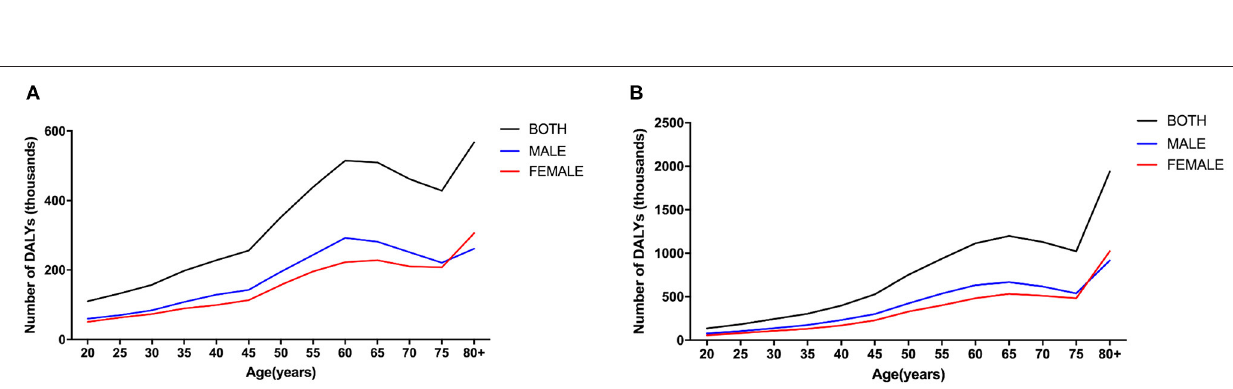
FIGURE 1 | Time trends in the global disease burden of CKD due to hypertension in 1990–2019. DALY numbers (A) , DALY rates (B) , and age-standardized DALY rates (C) . Dashed lines represent 95% confidence intervals. CKD, chronic kidney disease; DALY, disability-adjusted life-year.